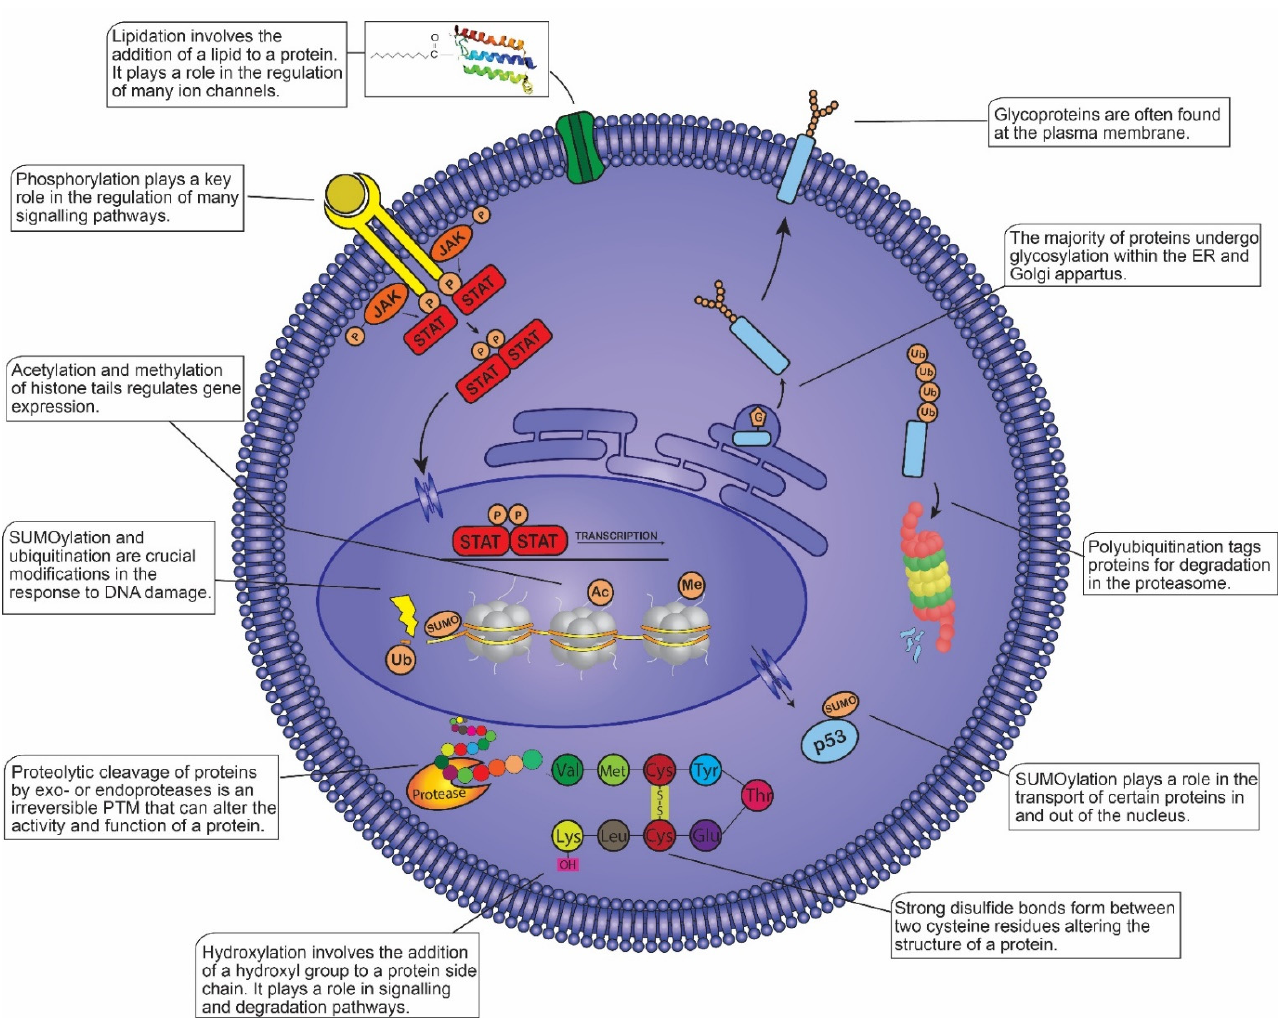
Figure 1. Post-translational modifications (PTMs) within the mammalian cell. This figure illustrates some of the most well-known PTMs and their functions within the cell. PTMs are found throughout the cell from the plasma membrane to the nucleosomes present within the nucleus. PTMs play crucial roles in almost all cellular processes including the cell cycle, degradation, apoptosis, cell signaling, transcription, etc. Different proteins modified by the same PTM will not always yield the same response, demonstrating the diverse functions of PTMs within the cell. JAK, Janus kinase; STAT, signal transducer and activator of transcription; P, phosphate group; G, glycosyl group; Ub, ubiquitin; SUMO, small ubiquitin-like modifier; Ac, acetyl group; Me, methyl group; Val, valine; Met, methionine; Cys, cysteine; Tyr, tyrosine; Glu, glutamic acid; Lys, lysine.